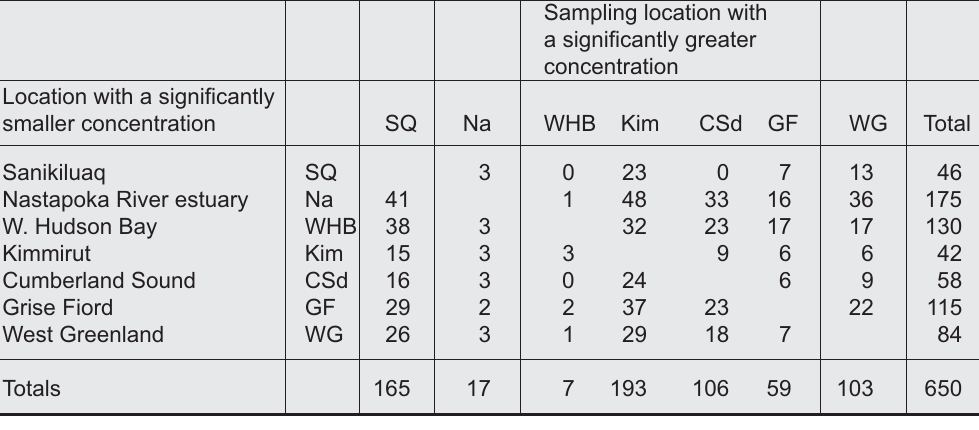
Table 2. Number of significant differences ( P < 0.05) found between sampling locations for the 64 organochlorine compounds measured in beluga blubber. SQ - Sanikiluaq, Na - Nastapoka River estuary, WHB - W. Hudson Bay, Kim - Kimmirut, CSd - Cumberland Sound, GF - Grise Fiord, WG - West Greenland.